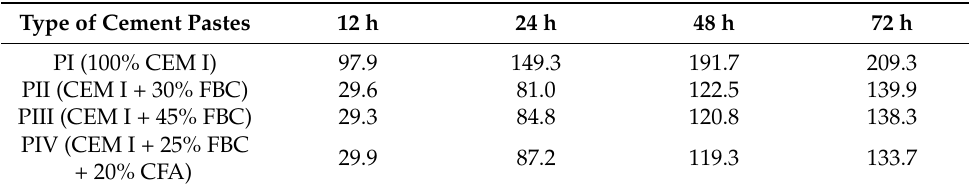
Figure 6. Total hydration heat evolved in cementitious and cement–ash pastes. Table 6. Hydration heat of cement pastes’ tested Q